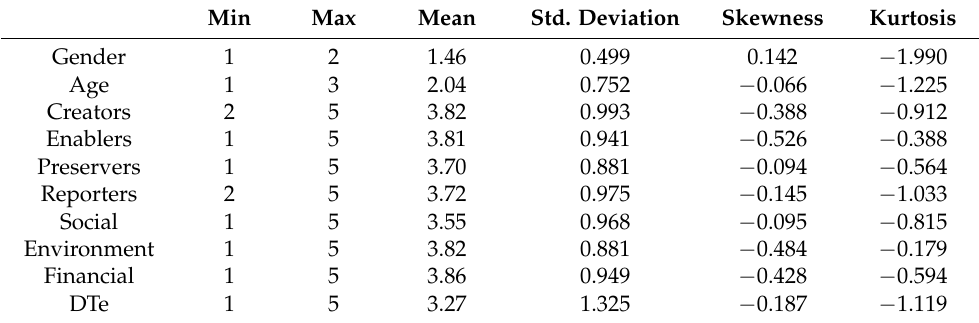
Table 2. Descriptive